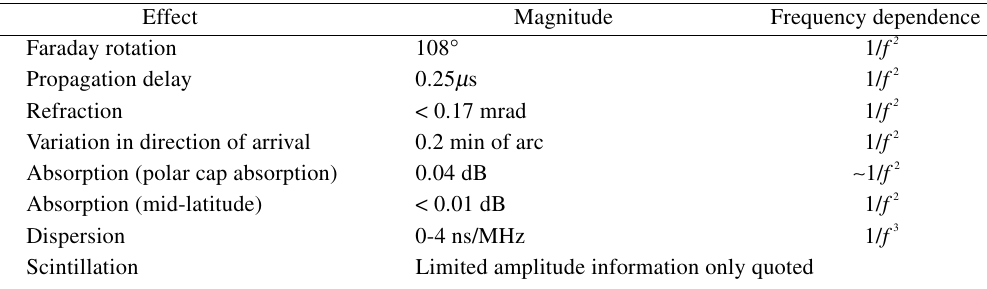
Table II. ITU-R Recommendation P.531 ‘estimated maximum